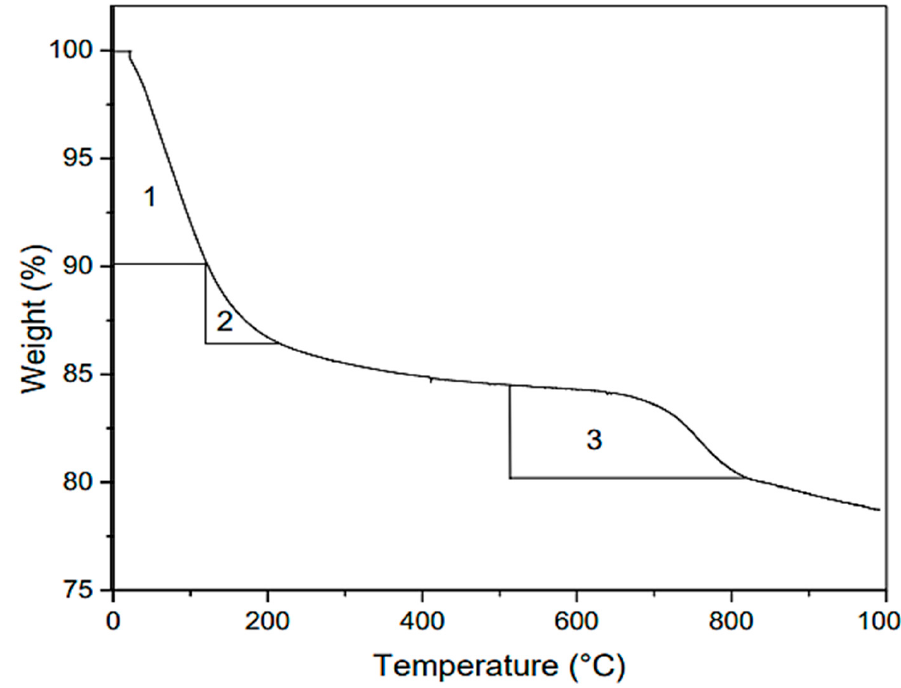
Figure 26. Thermogravimetric (TGA) analysis of geopolymer [94].